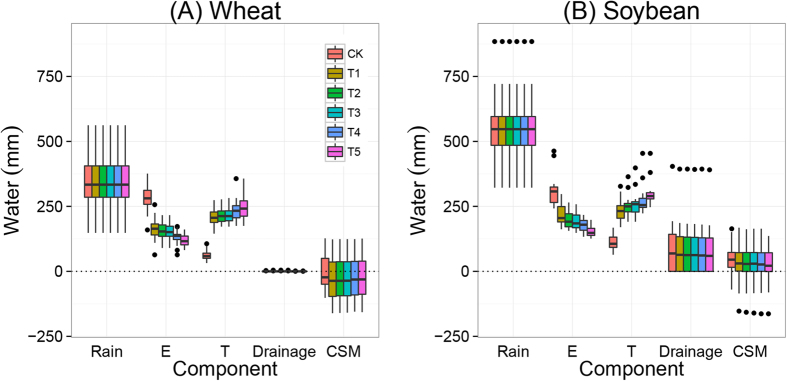
Water balance components for the wheat (A) and soybean (B) growing seasons during the period 1982–2012 as function of fertilization treatments: no fertilization (CK), mineral NPK (T1), NPK + low rate of straw (T2), NPK + high rate of straw (T3), NPK + pig manure (T4) and NPK + cattle manure (T5). Boxes show 25th and 75th percentiles (i.e. Q1 and Q3). Lines in the boxes show the median values. The components of water balance are shown on the x-axis, i.e., rainfall, soil evaporation (E), crop transpiration (T), drainage and changes in soil moisture (CSM). See formula (2) and text for explanations.